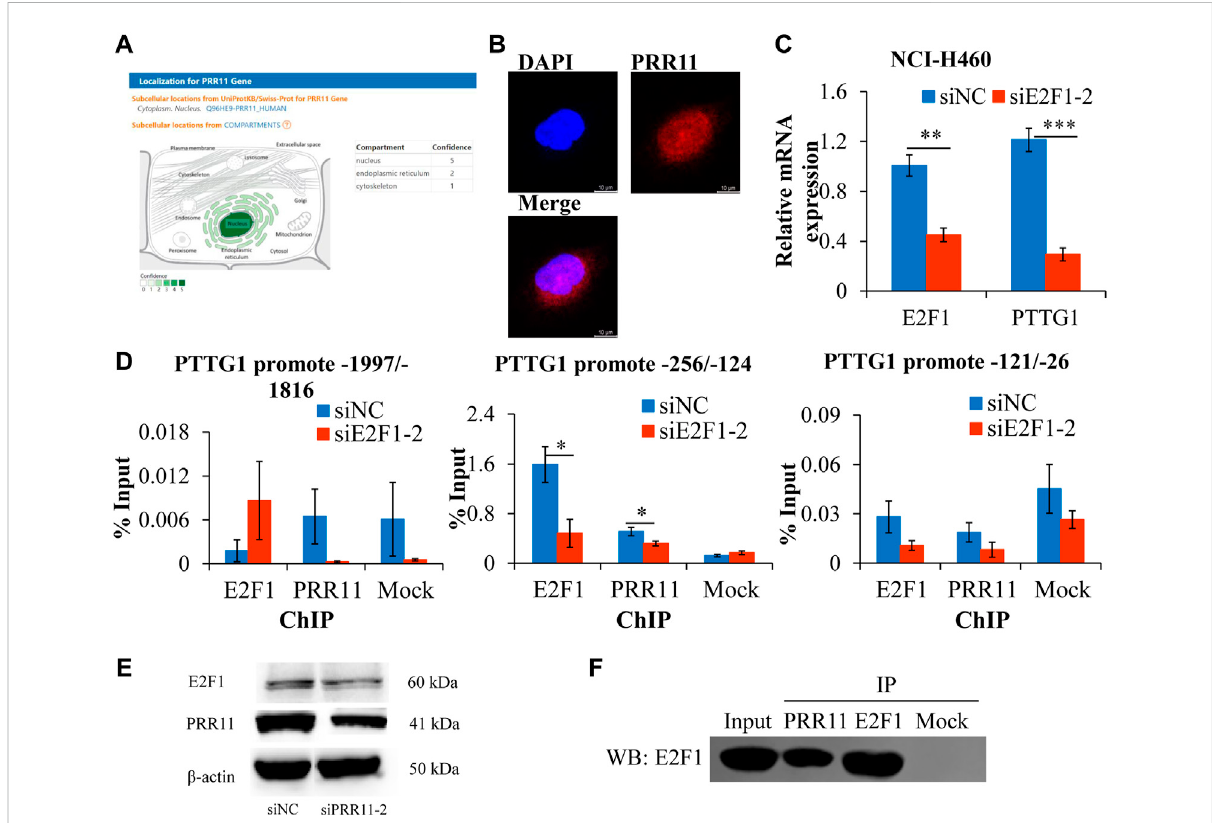
FIGURE 6 PRR11 promotes theexpression level ofPTTG1byinteractingwith E2F1. (A) Localizationfor PRR11gene wasanalyzed usingGeneCards (https:// www.genecards.org/). (B) Immuno fl uorescence localization of PRR11. (C) Expression levels of PTTG1 after interfering E2F1. (D) ChIP-qPCR of the PTTG1 promoter region. (E) Expression levels of E2F1 and PRR11 in NCI-H460 cells transfected with siNC or siPRR11 were examined by Western blotting. (F) Co-IP of PRR11 and E2F1 in NCI-H460 cells. N = 3. * p < 0.05, ** p < 0.01, and *** p <